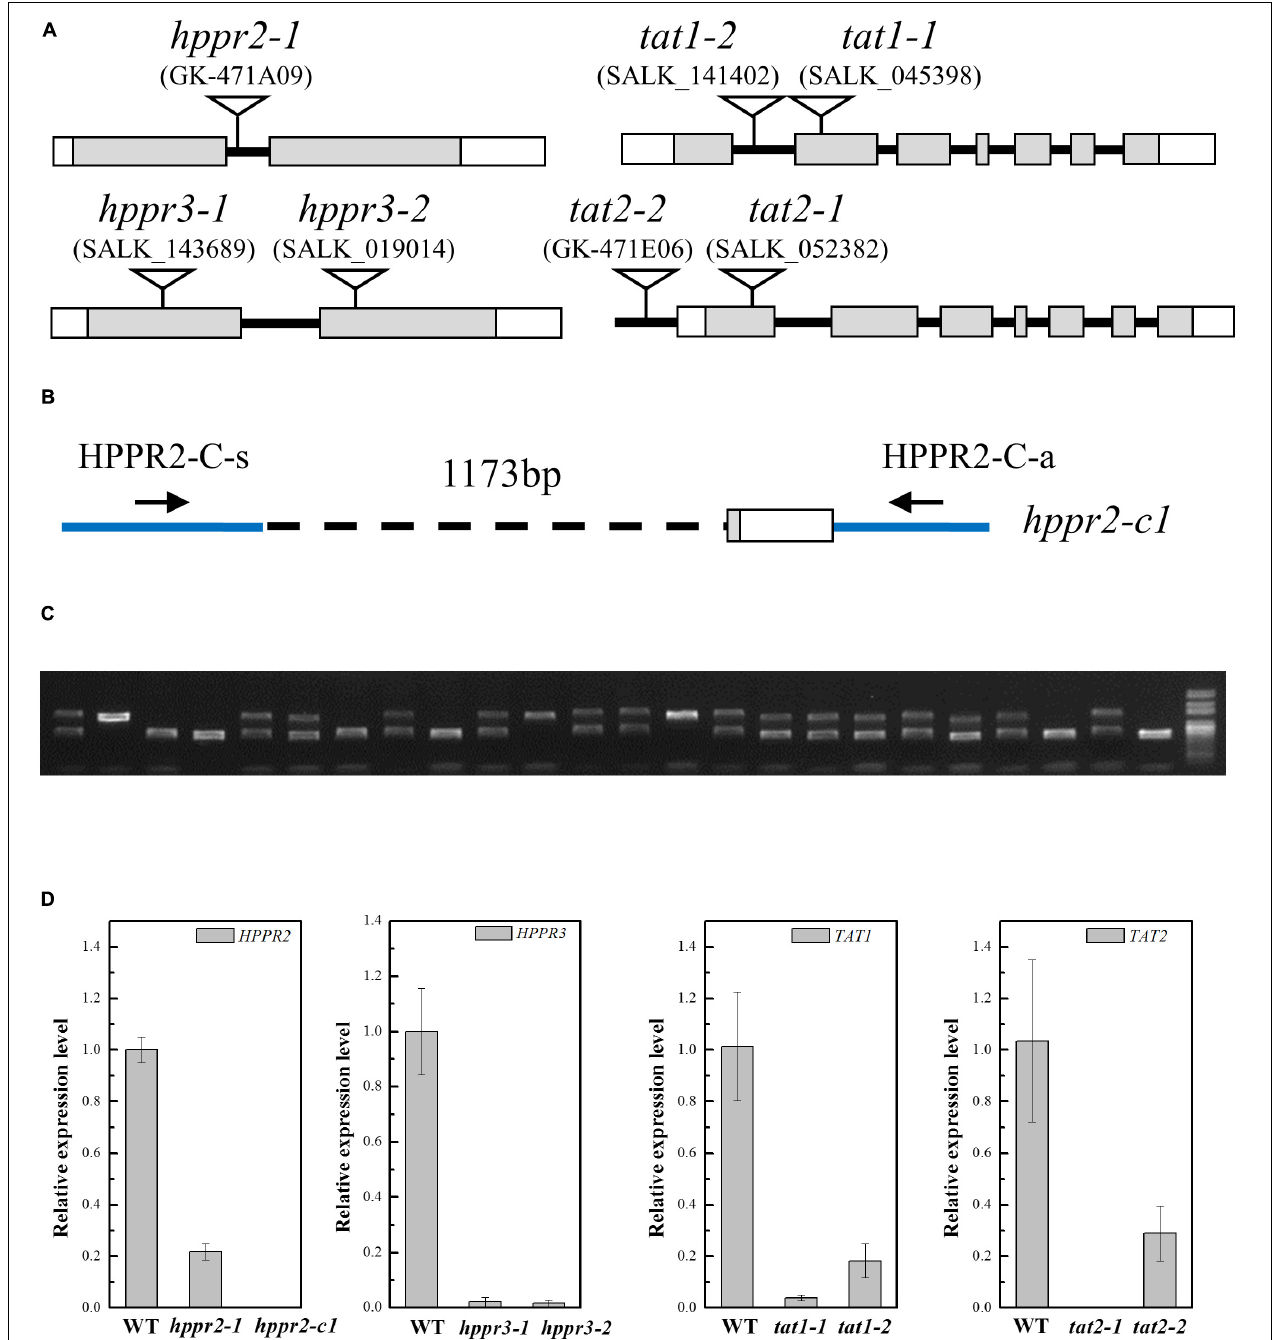
FIGURE 6 | Characterization of the hppr2 , hppr3 , tat1 , and tat2 mutants. (A) Schematic diagram of the T-DNA insertion in hppr2-1 , hppr3-1 , hppr3-2 , tat1-1 , tat1-2 , tat2-1 , and tat2-2 mutants. Exons and untranslated regions are indicated by gray and white boxes, respectively. (B) Schematic diagram showing the hppr2-c1 mutation, which was generated by CRISPR/Cas9. A 1173-bp fragment was detected in genomic DNA. HPPR2-C-s and HPPR-C-a are the primer pair used to confirm the deletion. (C) PCR analysis of DNA from T2 plants generated from a single T1 plant contained the hppr2-c1 mutation. (D) Quantitative reverse transcription PCR (qRT-PCR) analysis of HPPR2 , HPPR3 , TAT1 , and TAT2 transcript abundance in the wild type (WT) and the T-DNA mutants. Data are means of three biological replicates ±